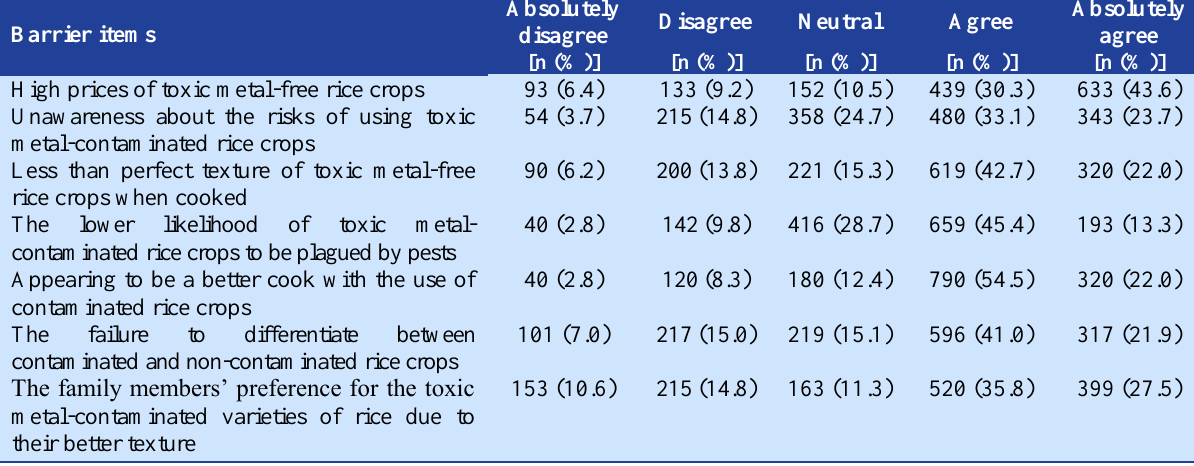
Table 3. Agreement/lack of agreement proportion across the barrier items Barrier